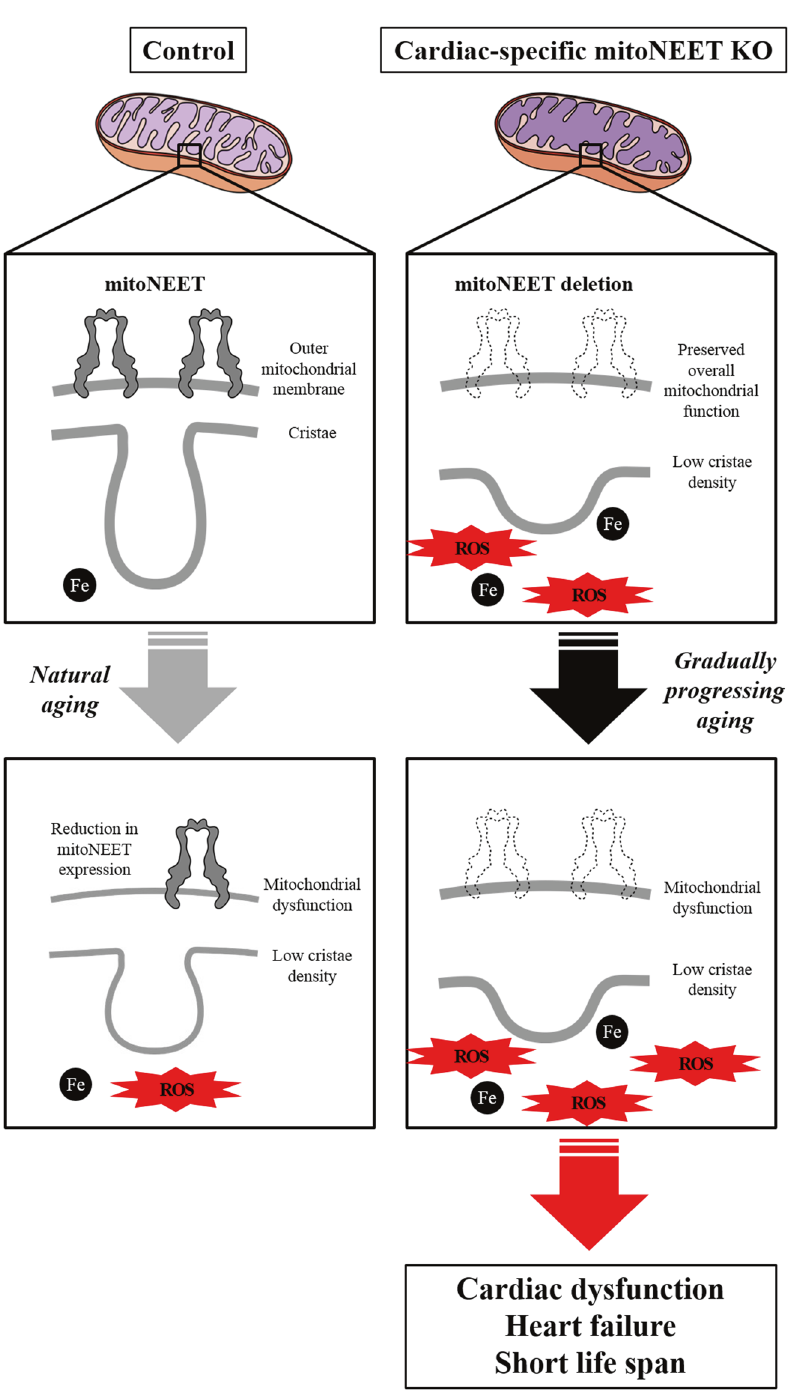
Fig. 6 Proposed mechanisms for causing age-associated heart failure by cardiac-speci fi c mitoNEET downregulation. The mitoNEET protein is speci fi cally downregulated in the hearts during normal aging. Deletion of mitoNEET primarily causes an impairment of mitochondrial integrity and a mitochondrial iron overload, and enhances ROS production, which secondarily leads to mitochondrial dysfunction. Enhanced ROS production leads to cardiac dysfunction and the development of heart failure, resulting in short life span. ROS, reactive oxygen